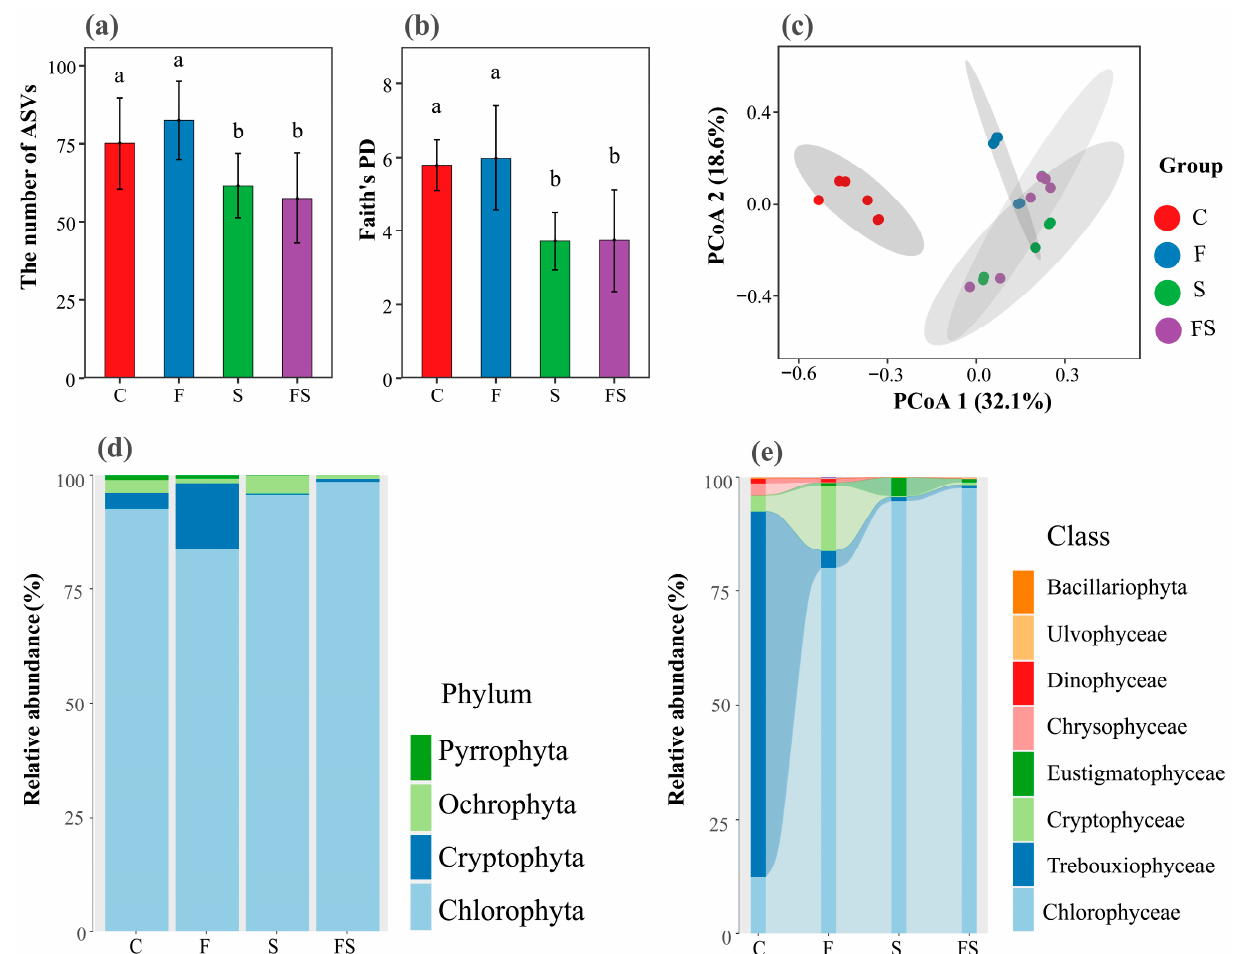
Figure 3. Phytoplankton alpha diversity and assemblage composition. ( a ) The number of phyto- plankton amplicon sequence variants (ASVs); ( b ) Faith’s phylogenetic diversity (Faith’s PD); ( c ) Principal coordinate analysis (PCoA) plot of phytoplankton assemblage composition; Phytoplank- ton taxonomic distribution at the phylum ( d ) and class ( e ) levels. C: Control, F: Fish-added treat- ment, S: Shrimp-added treatment, FS: Fish–shrimp-added treatment. Di ff erent le tt ers above the bars indicate signi fi cant di ff erences according to one-way ANOVA analysis. Table 2. ADONIS and ANOSIM tests for phytoplankton assemblage composition in di ff erent treat- ments.